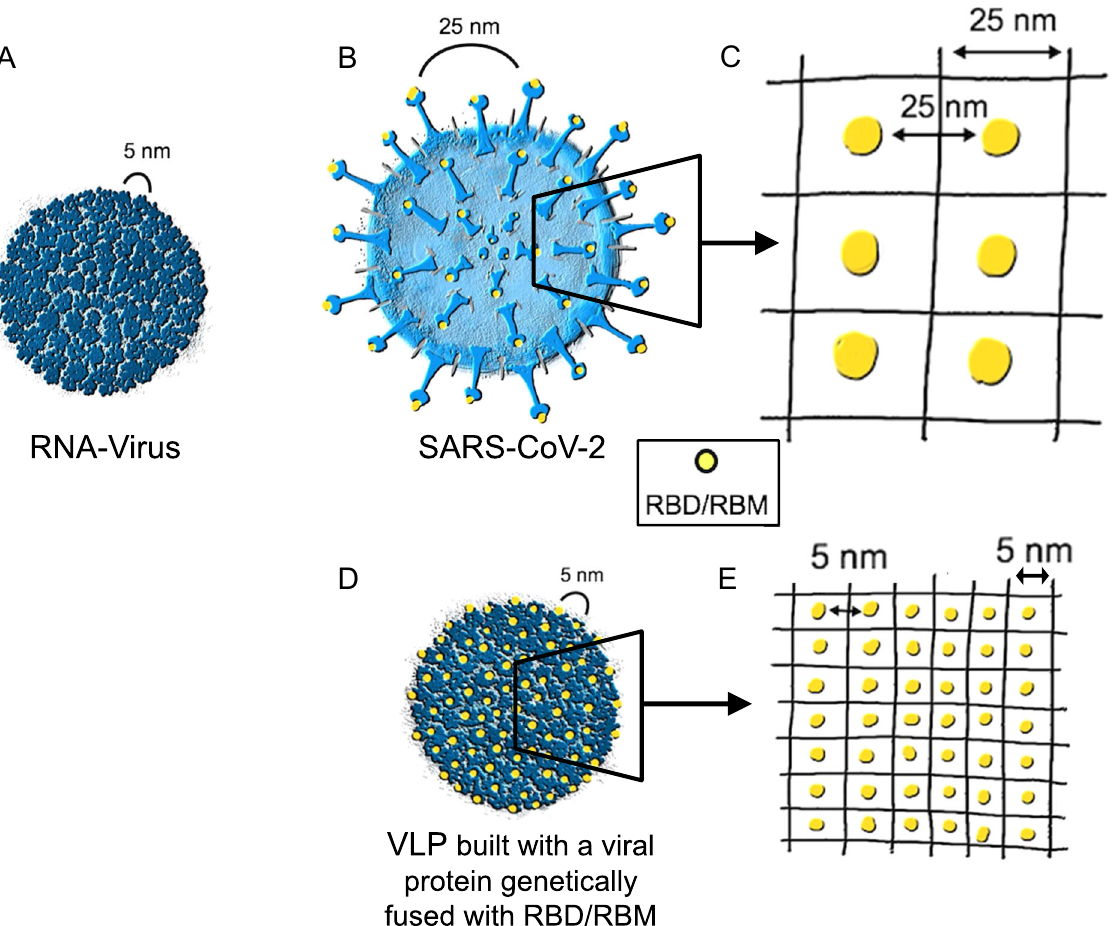
Fig. 2 Distances between neutralizing epitopes. A An example of a classical RNA virus with a capsule made of multiple copies of only one protein that are rigidly structured, displaying highly immunogenic repetitive neutralizing epitopes spaced by 5 – 10 nm. This virus is built with 180 monomers and has a total viral diameter of 30 nm. B , C A coronavirus with its S proteins, showing the distance of the neutralizing epitopes of about 25 nm, which is large and unfavorable for triggering antibody responses. D , E A virus-like particle (VLP) built by a viral protein into which the RBM of SARS-CoV-2 is genetically inserted. This VLP displays the neutralizing epitopes with an optimized spacing of 5